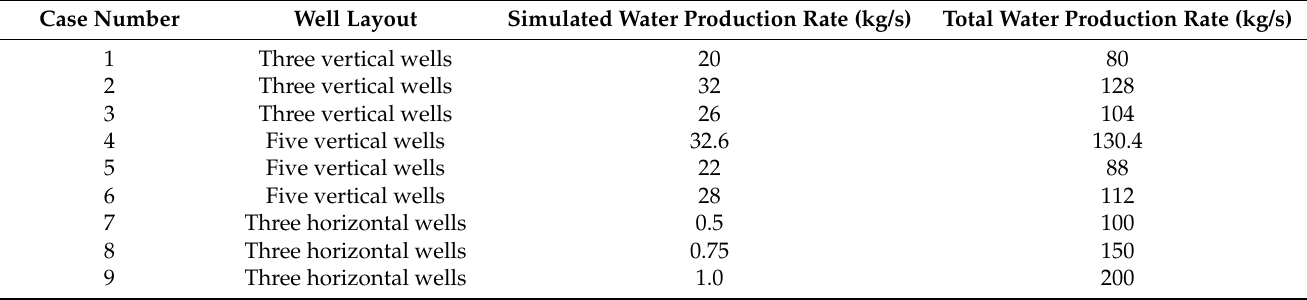
Table 3. The well layout and water production rate corresponding to every simulation